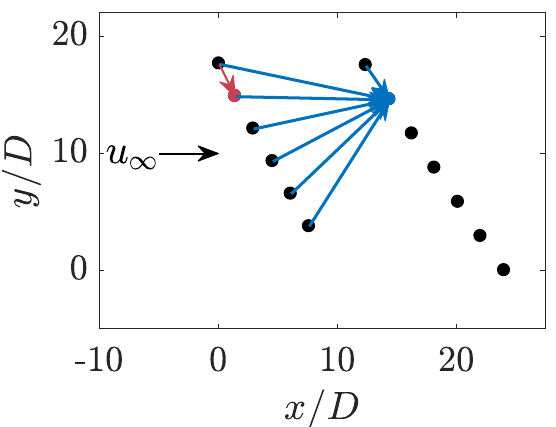
Figure 1. Diagram of the statistical model architecture. The dots represent wind turbines with flow from left to right. The power production of all upstream turbines are used for the power prediction of a given downstream turbine. The red arrows denote the weighted connection of the upstream turbine to the downstream red turbine. The blue arrows denote the weighted connection of the upstream turbines to the downstream blue turbine.